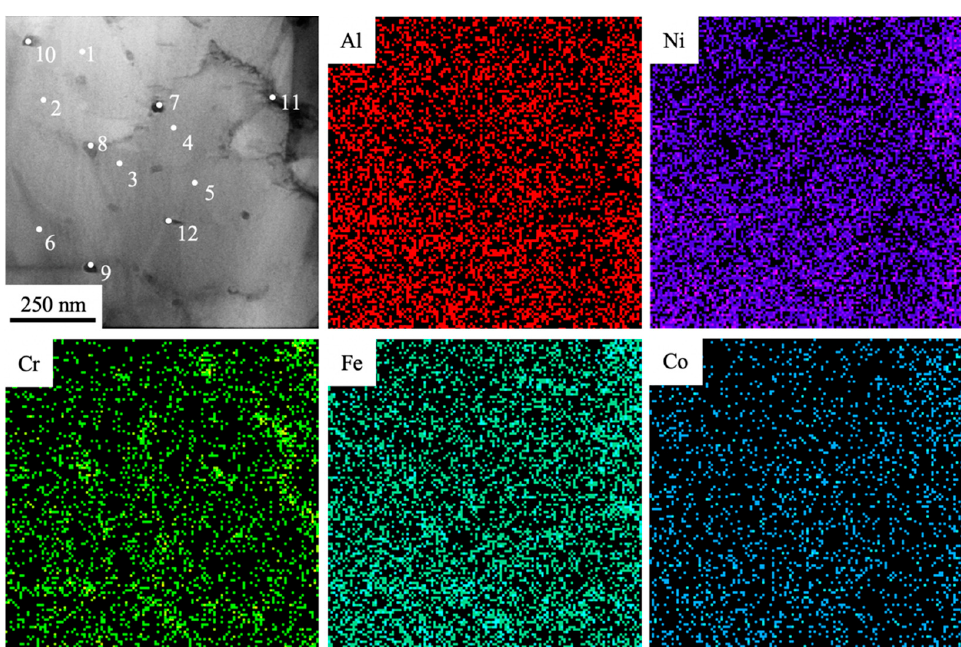
Figure 6. The TEM-EDS elemental mapping of the fabricated Al-Co-Cr-Fe-Ni HEA via wire-arc additive manufacturing and irradiated by HCPEB (20 J/cm 2 , 50 µ s, 3 pulses, 0.3 s − 1 ). Table 3. The TEM-EDS elemental mapping outcomes (at. %) of the foil section presented in Figure 6. No.